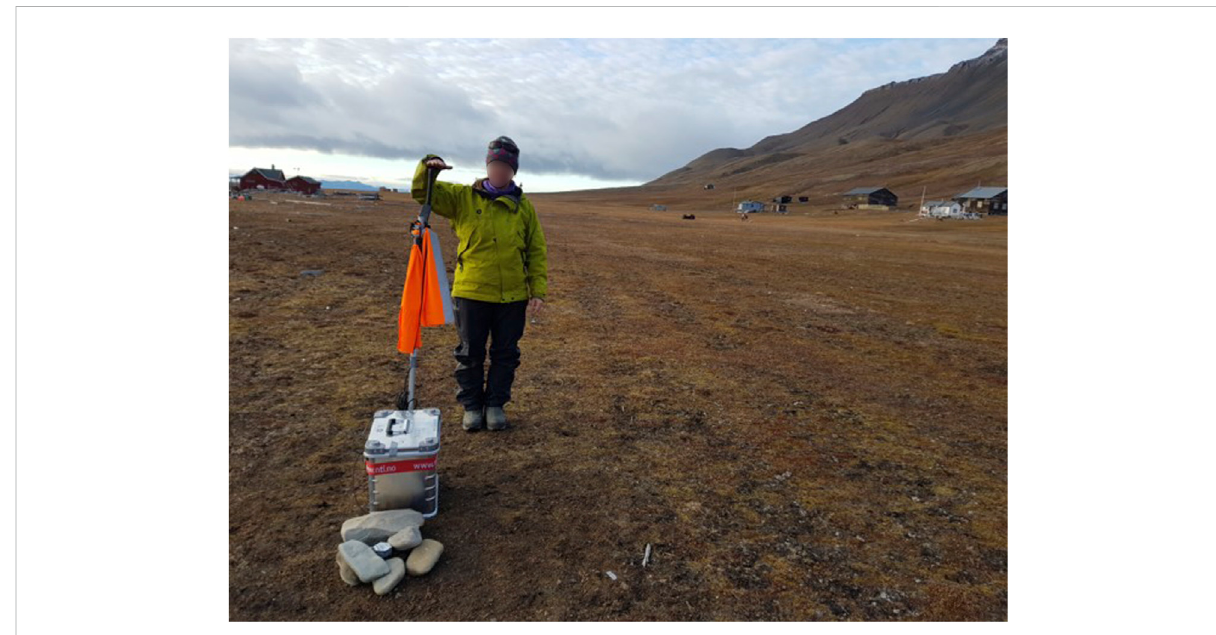
FIGURE 5 The monitoring station at Hiorthhamn, Svalbard. Photo: Andy Hodson, UNIS 2020.